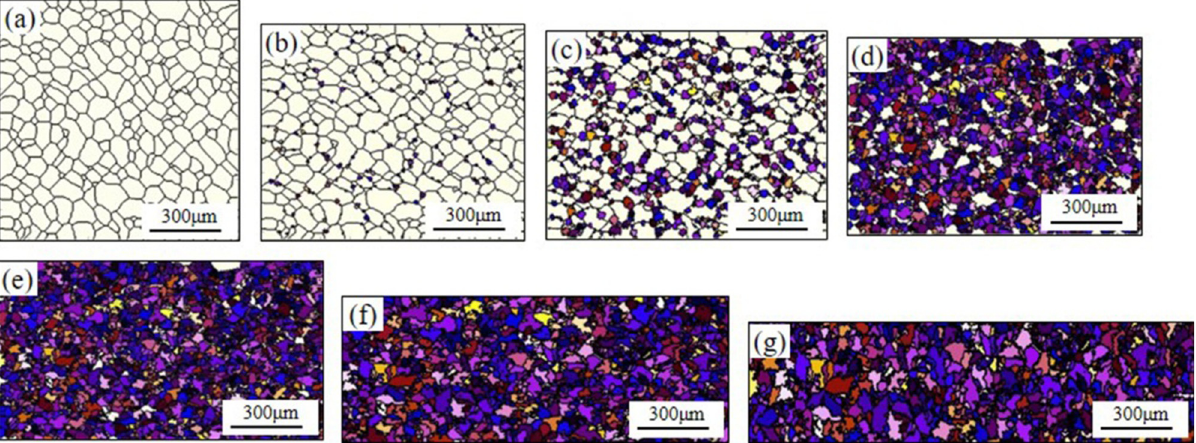
Fig. 4. AZ61 microstructure of simulation result under hot deformation with different e (400 ° C, _ e =0.001 s (cid:1) 1 ): (a) e t =0, (b) e t =0.1, (c) e t =0.15, (d) e t =0.2, (e) e t =0.3, (f) e t =0.5, (g) e t =0.7.